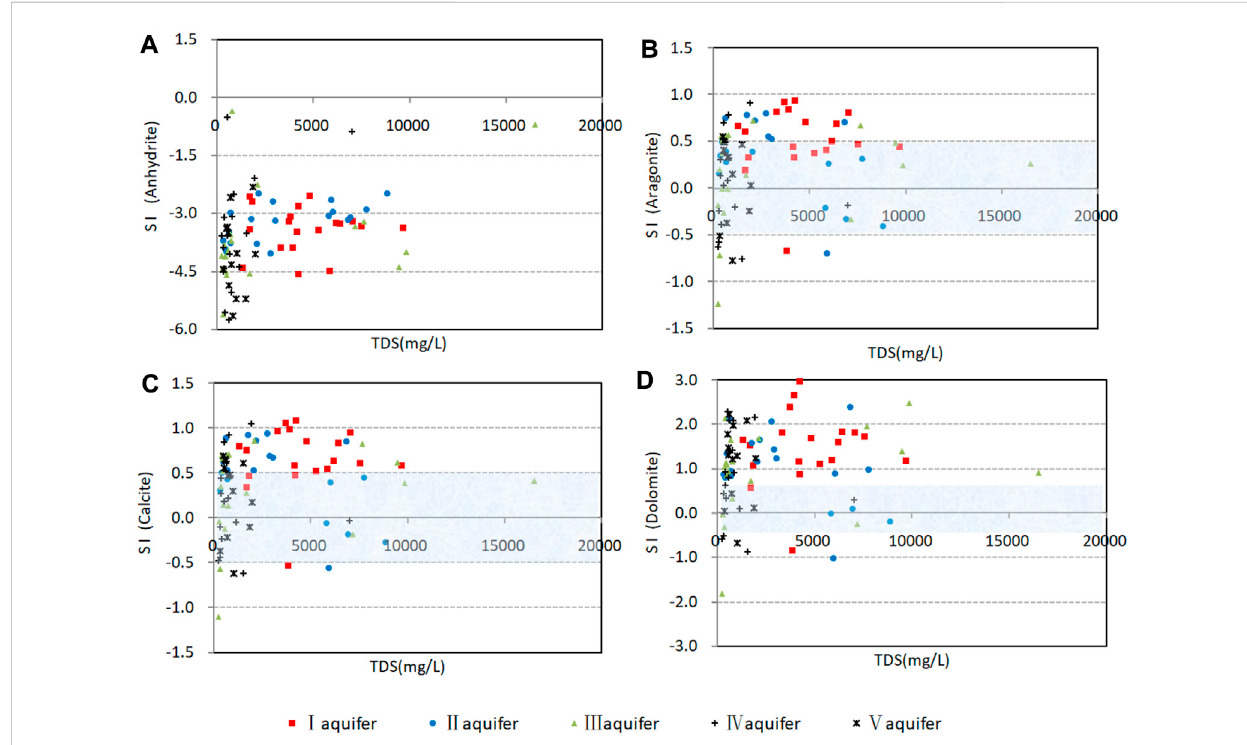
FIGURE 10 Saturation indices of con fi ned groundwater in the study area. (A) Saturation indices values for anhydrite. (B) Saturation indices values for aragonite. (C) Saturation indices values for calcite. (D) Saturation indices values for